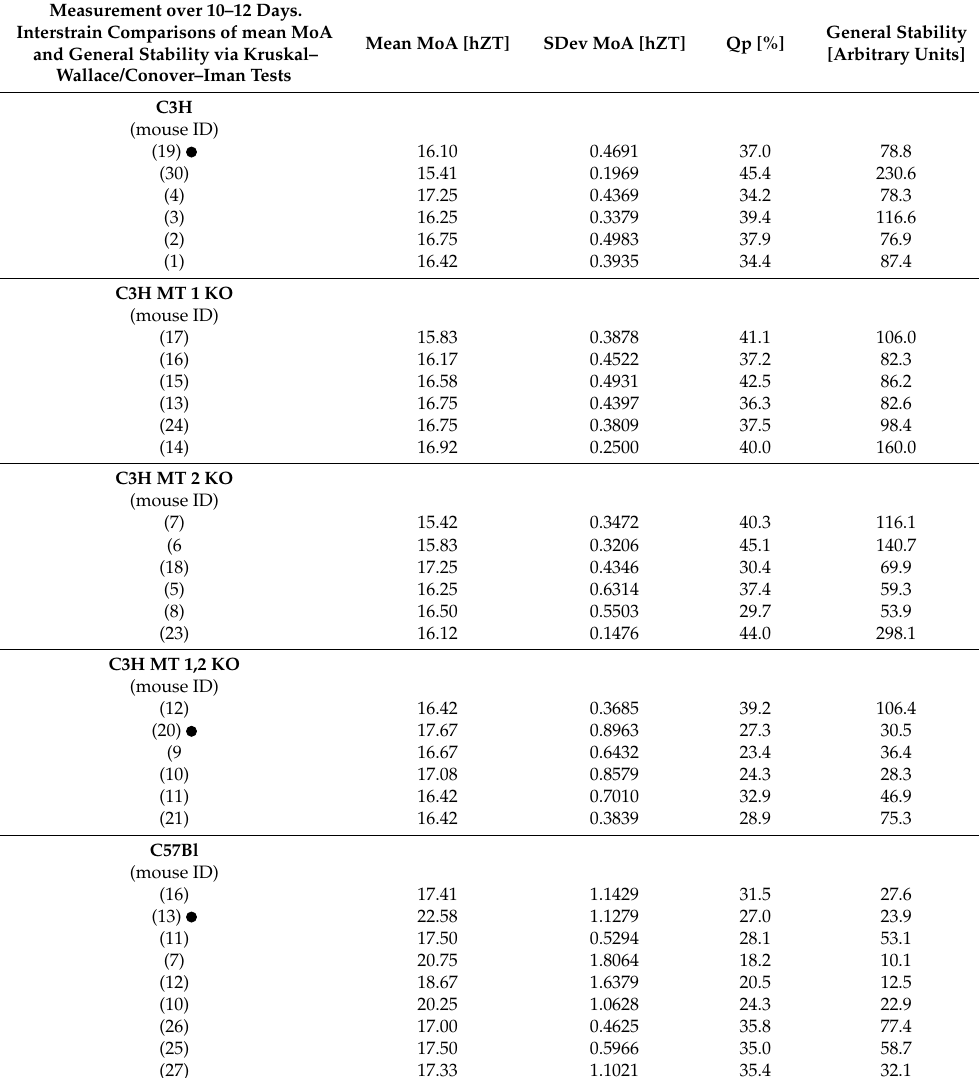
Table 1. Raw data and statistical methods. Bullets: Actograms from these mice are shown in Figure 2. Measurement over 10–12 Days. Interstrain Comparisons of mean